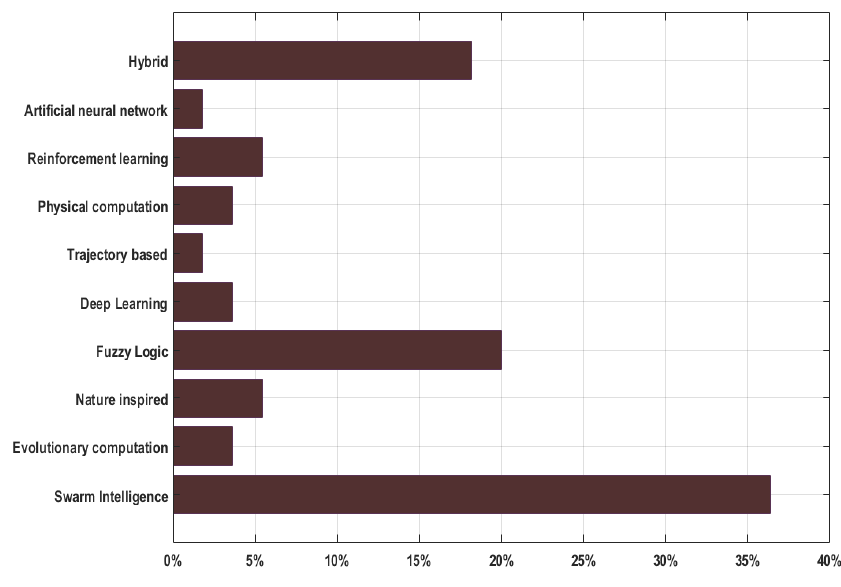
Figure 5. AI methods with respect to various challenges in